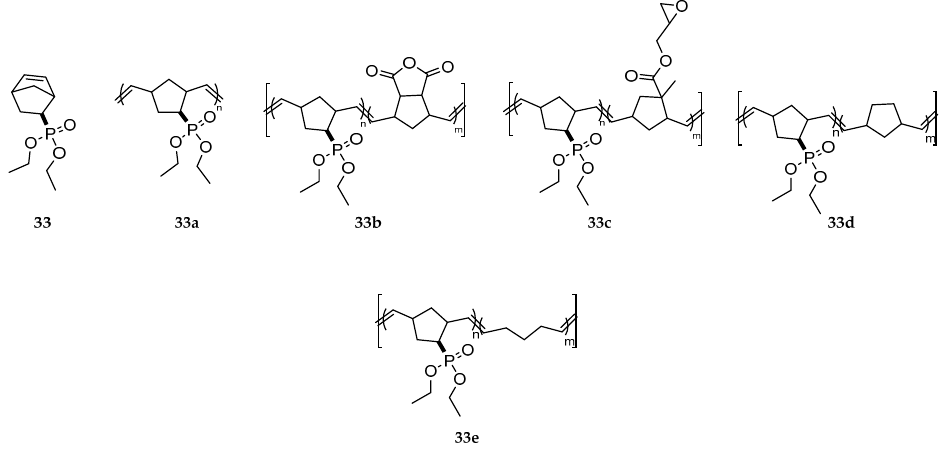
Figure 12. Monomer 33 and its corresponding polymers.